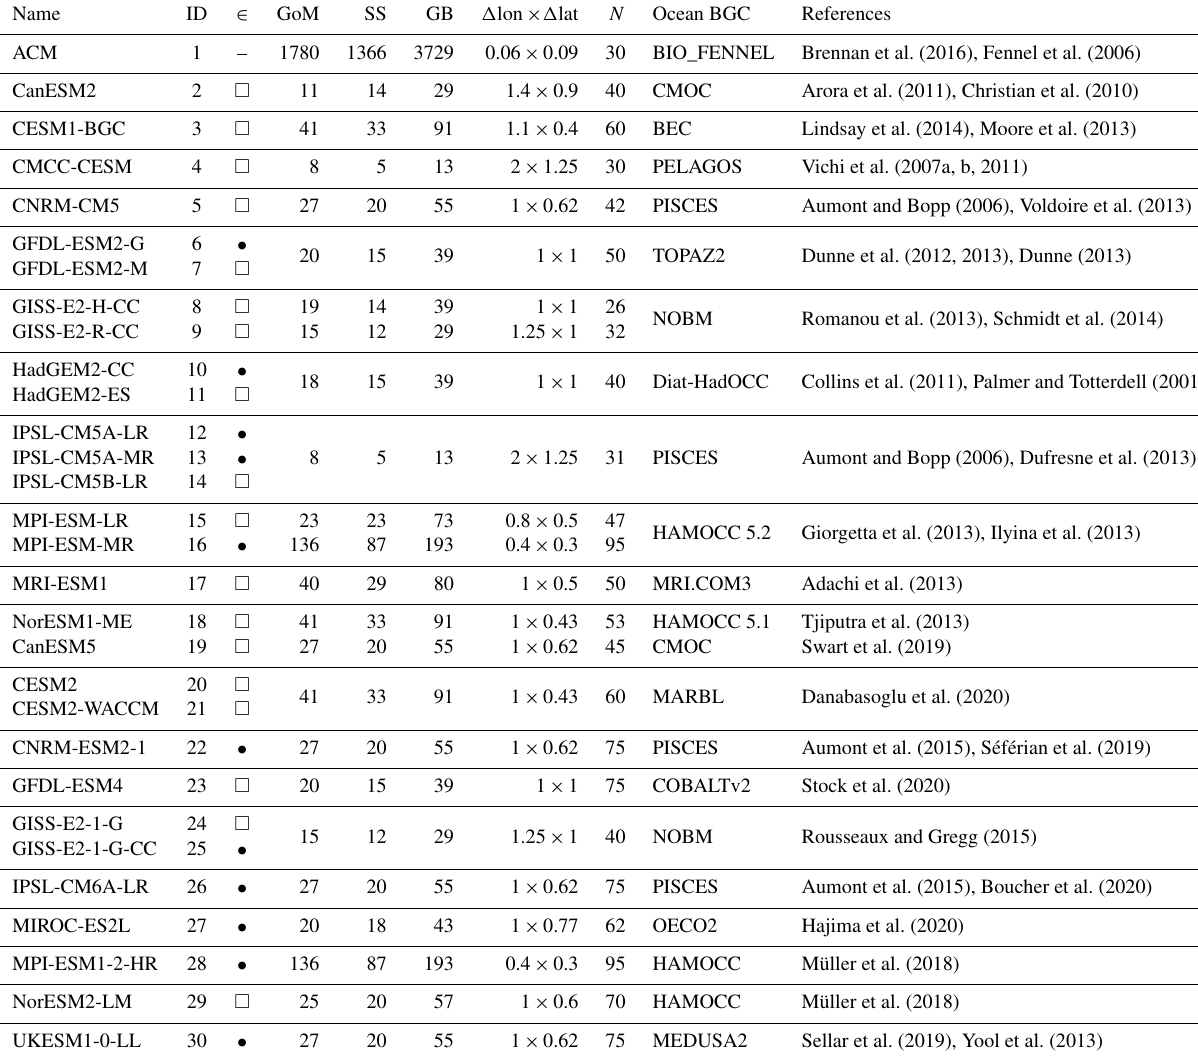
Table 1. Information about the regional model and the 29 ESM models. For the CMIP5 models (2–18) the r1i1p1 ensemble was used. For the CMIP6 model (19–30) the r1i1p1f1 ensemble was used on the native grid when available, except for CNRM-ESM2-1, MIROC-ES2L and UKESM1-0-LL (r1i1p1f2), GFDL-ESM4 and NorESM2-LM (regridded), and GISS-E2-1-G (r101i1p1f1). The filled circles and open squares indicate the models that are part of the inner and outer ensembles, respectively. The table provides the number of grid cells in the GoM, SS and GB regions, the average grid resolution on the shelf ( (cid:49) lon × (cid:49) lat, degrees) and the number of vertical levels ( N ). Note that the IPSL-CM5 models share the same ocean component with higher resolution atmospheric component in the MR version. Similarly, MPI-ESM-MR and MPI-ESM1-2-HR share the same ocean component with higher resolution atmospheric component in the HR